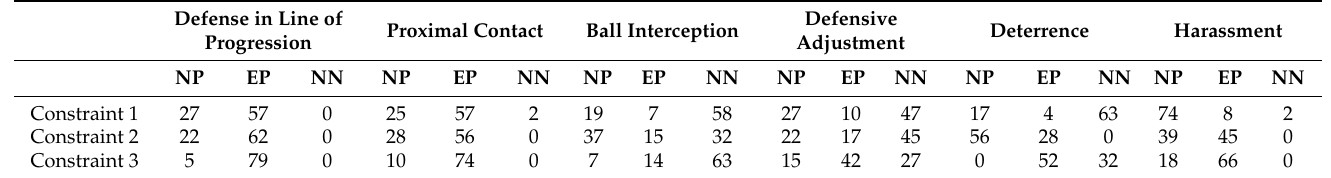
Table 2. Descriptive Analysis of observed Actions regarding Handball’s Motor Behaviors (a).